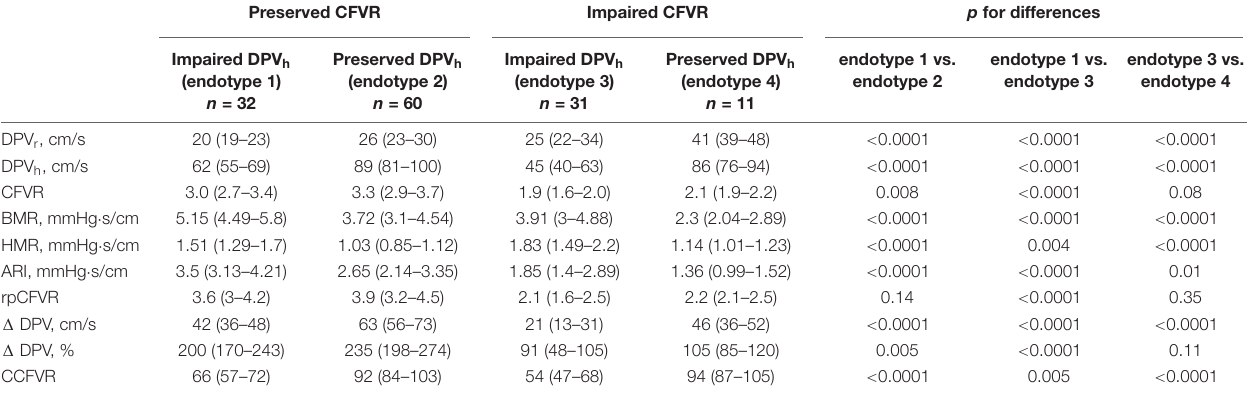
TABLE 2 | Hemodynamic and microvascular coronary flow parameters in heart transplant patients stratified by 4 endotypes. Preserved CFVR Impaired CFVR p for differences